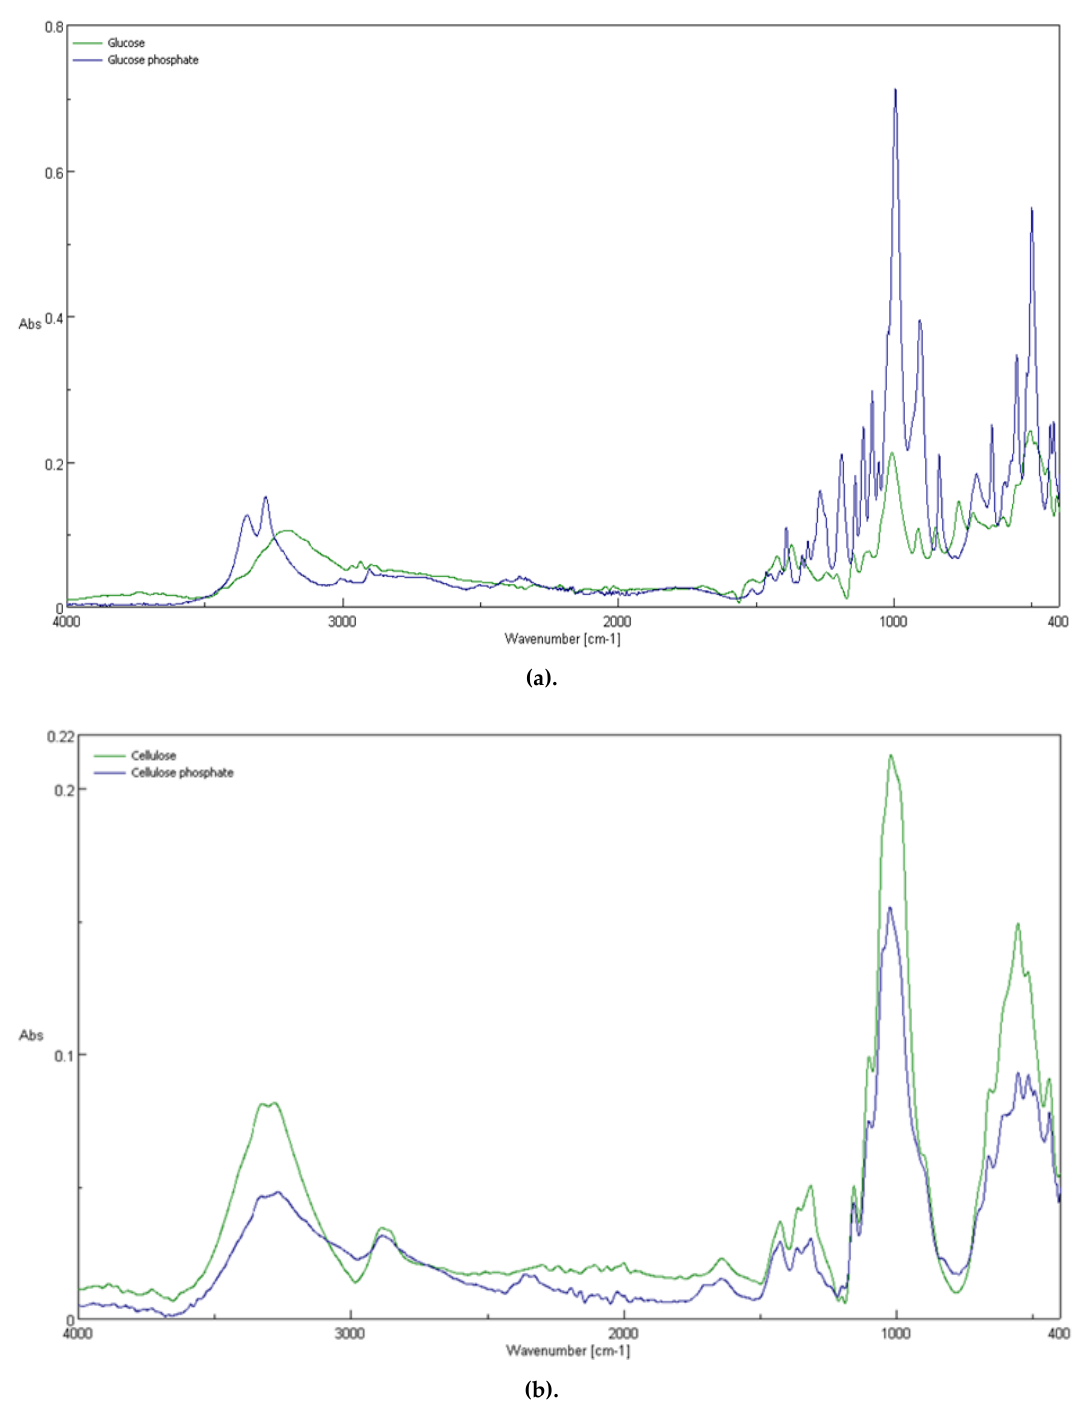
Figure 10. Comparison of attenuated total reflection Fourier transform infrared (ATR-FTIR) spectra of: ( a ) glucose and glucose phosphate (V) (Sigma – Aldrich); ( b ) cellulose (Avicel) and cellulose- O -phosphate(V) Cell- O -P(O)(OH) 2 (Sigma- Aldrich).